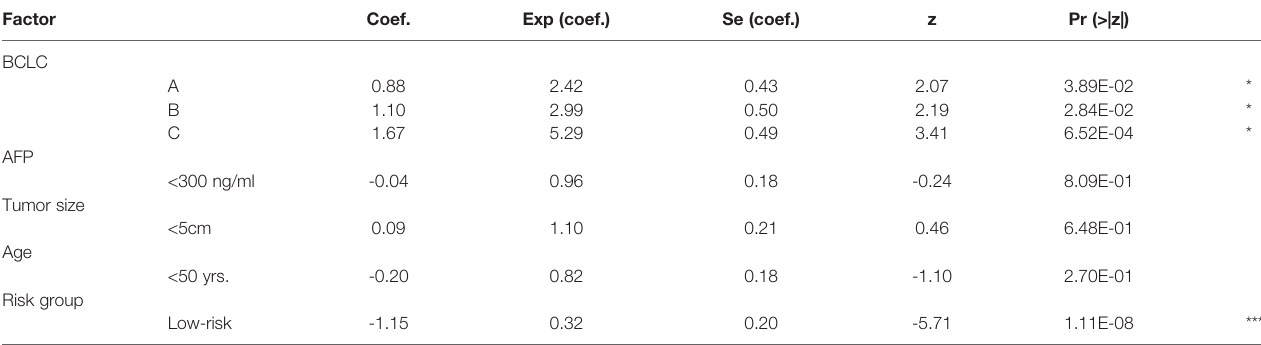
TABLE 1 | The coef fi cients and statistical signi fi cance of the risk strati fi cation and four prognostic factors in the multivariable model (training cohort). Factor